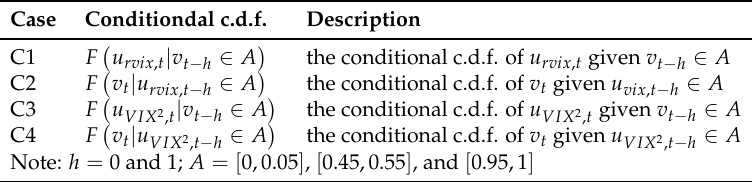
Table 3. The List of Conditional Cumulative Distributions of Interest.